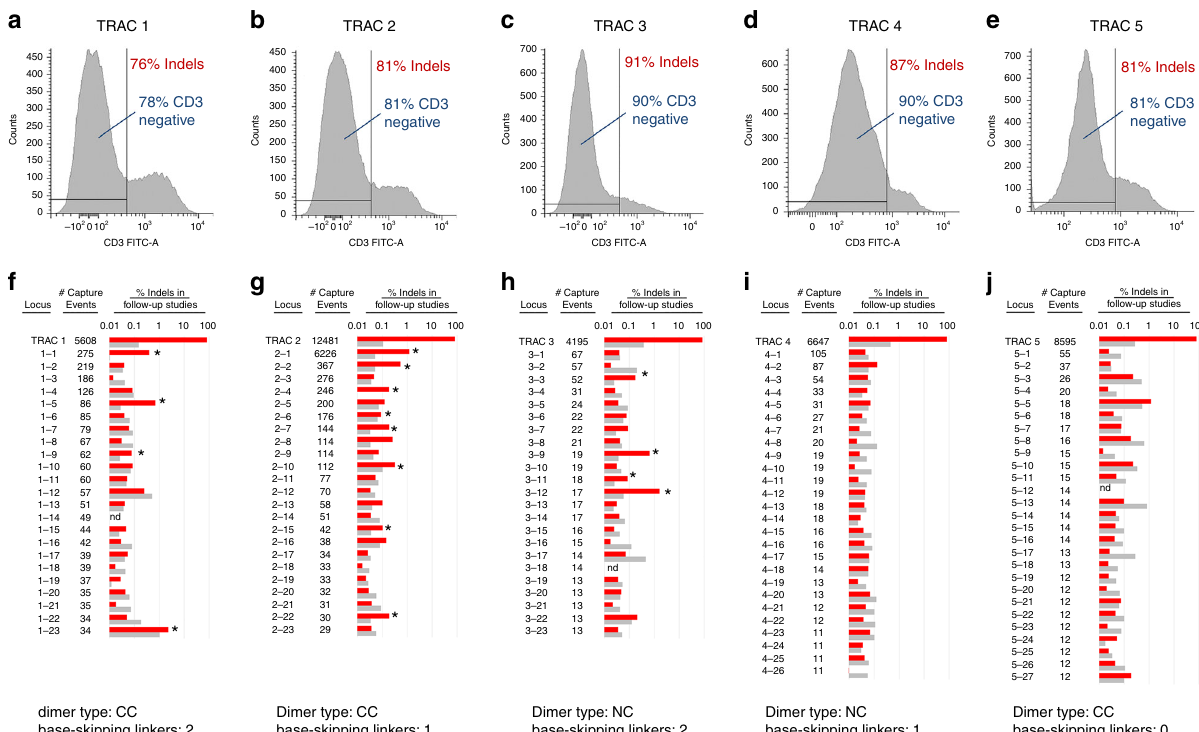
Fig. 5 Phenotypic analysis and speci fi city assessment of ZFNs targeting TRAC. Across the top are shown names of the distinct sites targeted by each pair of ZFNs (Supplementary Fig. 21). Underneath each label are two panels containing the data for the indicated pair (e.g., a and f for TRAC 1, b and g for TRAC 2, etc.). Architecture information is indicated at the bottom. a – e Phenotypic characterization of ZFN-treated T-cells. Histograms for each pair were generated via analysis of 10,000 cells and plots are shown for each of the indicated pairs with the percentage of cells that are negative for CD3 annotated on each graph. CD3 is a component of the T-cell receptor complex queried as a proxy for TRAC surface disruption. Also shown on each plot are the corresponding % indels induced by each ZFN pair in this transfection. Plots for mock transfected T-cells are shown in Supplementary Fig. 22. f – j Speci fi city assessment of TRAC ZFNs. Candidate off-target loci were fi rst identi fi ed for each pair using an unbiased oligonucleotide duplex-capture assay in K562 cells. In a follow-up study, ZFN-encoding mRNA for each pair was transfected into activated T-cells via BTX transfection. Modi fi cation was monitored at each on- and off-target locus by PCR followed by deep sequencing (MiSeq). The off-target characterization for each pair is shown under the corresponding fl ow cytometry data. On the left of each bottom panel is a table with the locus being monitored (on-target locus at top) and the number of sequences recovered in the capture assay. To the right, log-scale bar graphs are shown that summarize off-target modi fi cation in the follow-up indel study. The red bars indicate the % indels for the ZFN-treated T-cells and the gray bars indicate the % indels observed in T-cells treated with mRNA expressing GFP. Candidate loci that were signi fi cantly modi fi ed in ZFN-treated cells as compared with GFP-treated controls are marked with an asterisk. Statistical signi fi cance was determined as previously described 77 combined with a Bonferroni correction. Each bar represents a single measurement. An expanded dataset for this study is provided in Supplementary Fig. 23. The source data for this fi gure is available in the Source Data fi